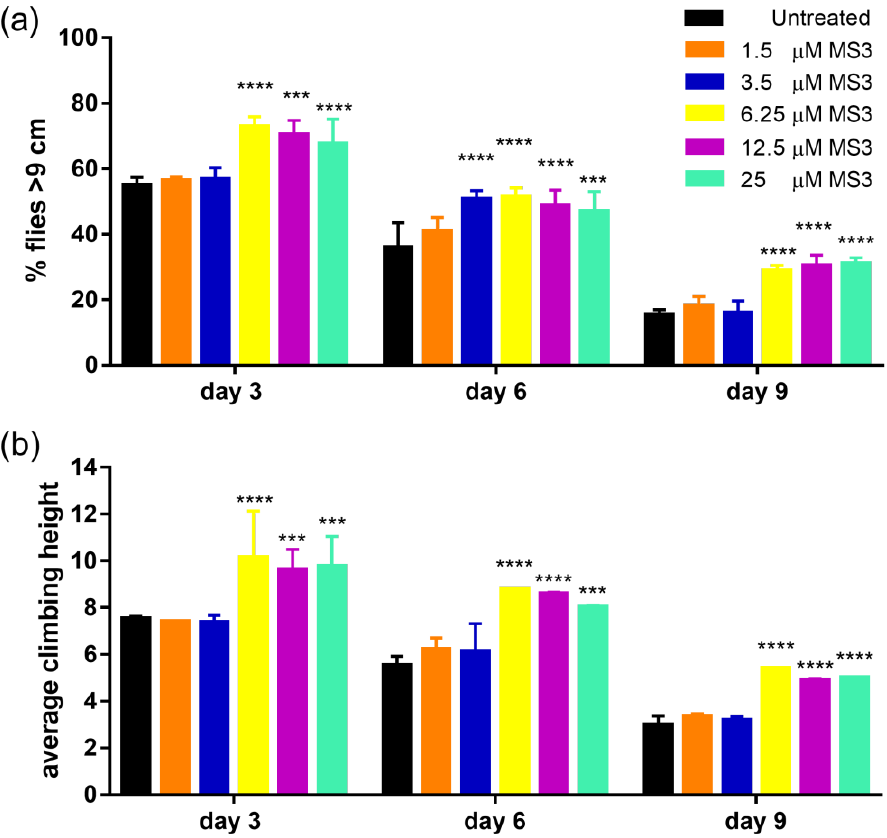
Figure 8. Climbing ability of age-matched adult female flies grown on food supplemented with different doses of MS3, evaluated at four different points: presymptomatic (pre-HD; 1 day post-eclosion, not shown), early symptomatic (early-HD; 3 days post-eclosion) and late symptomatic (late-HD; 6 and 9 days post-eclosion). ( a ) Percentage of treated flies that climbed over 9 cm was higher in comparison to sibling flies in a dose-dependent manner; ( b ) average climbing height reached by treated and untreated flies, both in pre- and late symptomatic periods. For each condition, the climbing ability of three groups of 20 flies was monitored ( n = 60) for a total of 3 trials ( n = 180). Analysis of data was conducted using ANOVA one way; data represents mean ± SEM (**** p < 0.0001; *** p < 0.001; compared with untreated as control).